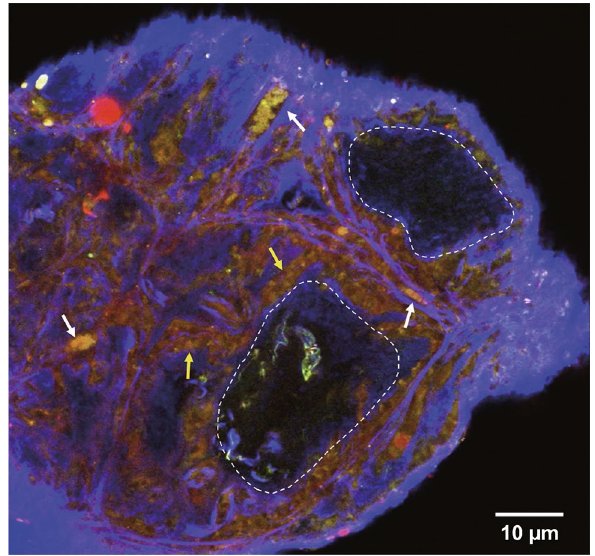
Fig. 10 Multiphoton microscopy of the stained microsphere scaf- folds after 14 days